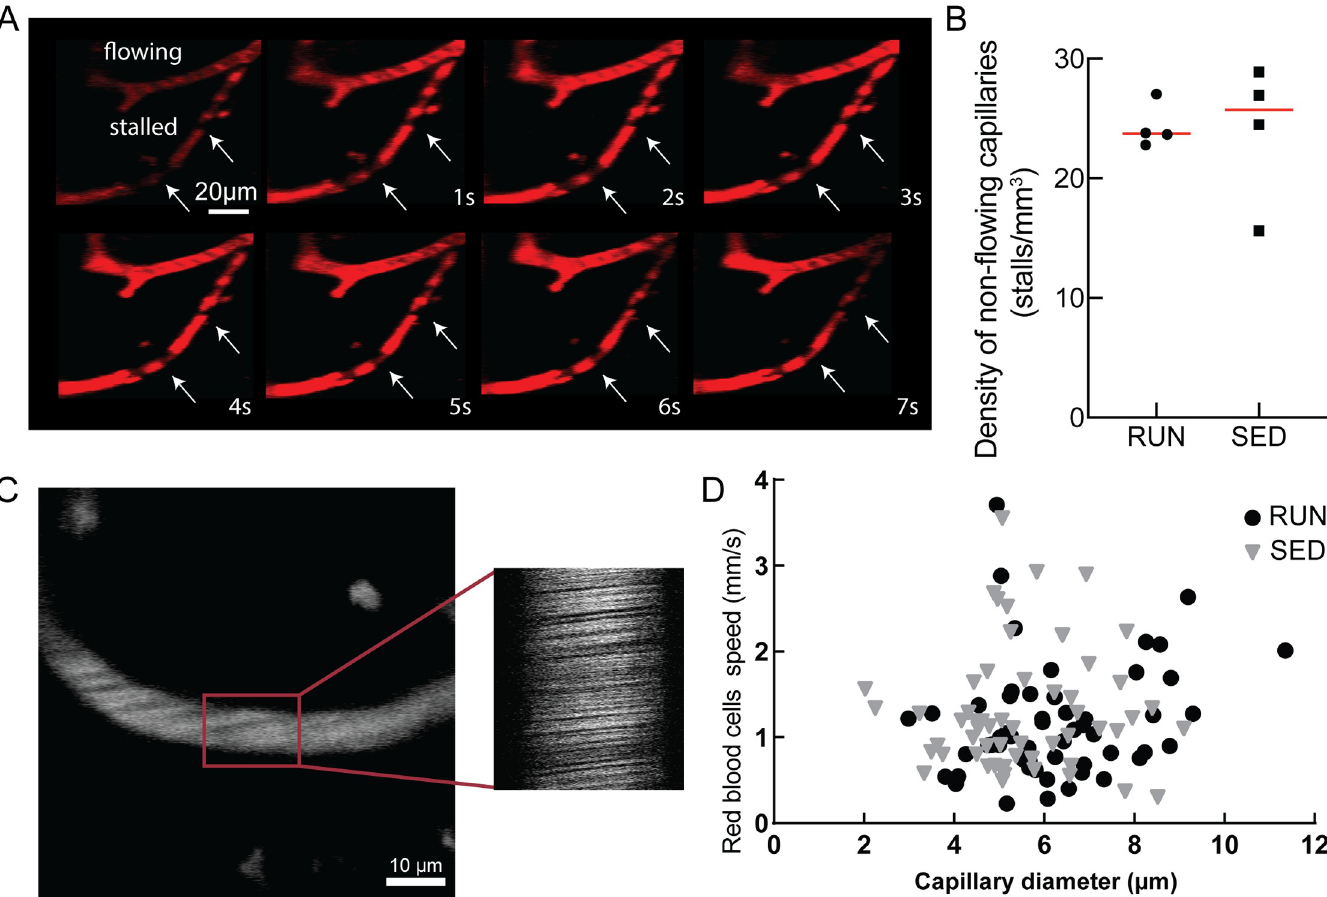
Fig 6. Running did not decrease the incidence of non-flowing capillaries, not increase capillary blood flow in the brain of APP/PS1 mice. A Representative 2PEF image sequence showing both flowing and stalled capillary segments over 7 s. The blood plasma was labeled with Texas Red-dextran and the dark patches in the vessel lumen were formed by blood cells. The lack of motion of these dark patches in the lower capillary indicates stalled blood flow. (Stalled capillary is indicated with arrows). B Density of capillaries with stalled blood flow in running (RUN) and sedentary (SED) APP/PS1 mice. C Representative 2PEF image of a cortical capillary (left) and a space-time image from repetitive line scans along the centerline of the capillary segment (right). The diagonal streaks in the space-time image are formed by moving red blood cells, with a slope that is inversely proportional to the blood flow speed. D Capillary blood flow speed plotted as a function of vessel diameter for cortical capillaries from running (RUN) and sedentary (SED) APP/PS1 mice (points represent individual capillary measurements; 15 vessels were measured per mouse; nested two-way ANOVA).